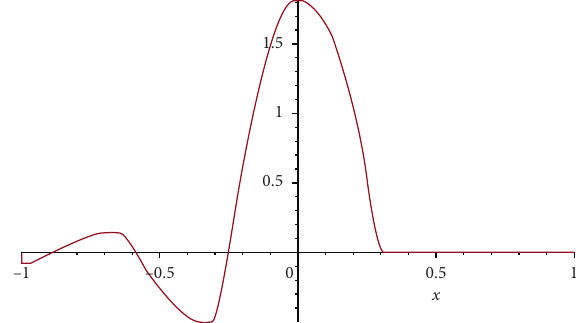
Figure 5: Illustration of the basis function Ψ ) i calized in the segment [ − 1, 1].